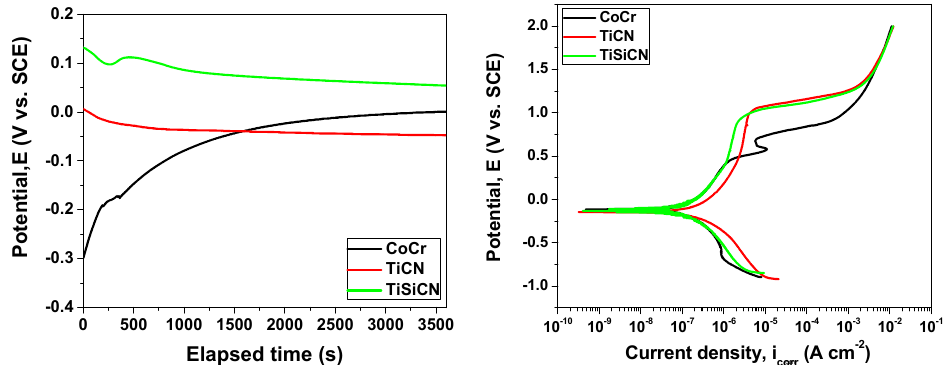
Figure 4. ( a ) Open circuit potential evolution in time and ( b ) potentiodynamic curves of the investigated